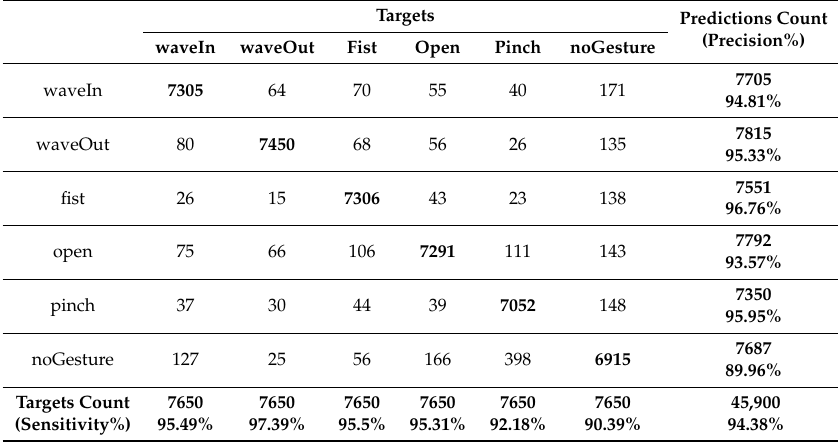
Table A7. Confusion matrix for experiment 3 . Synchronization gestures ( sync = 1 ) .